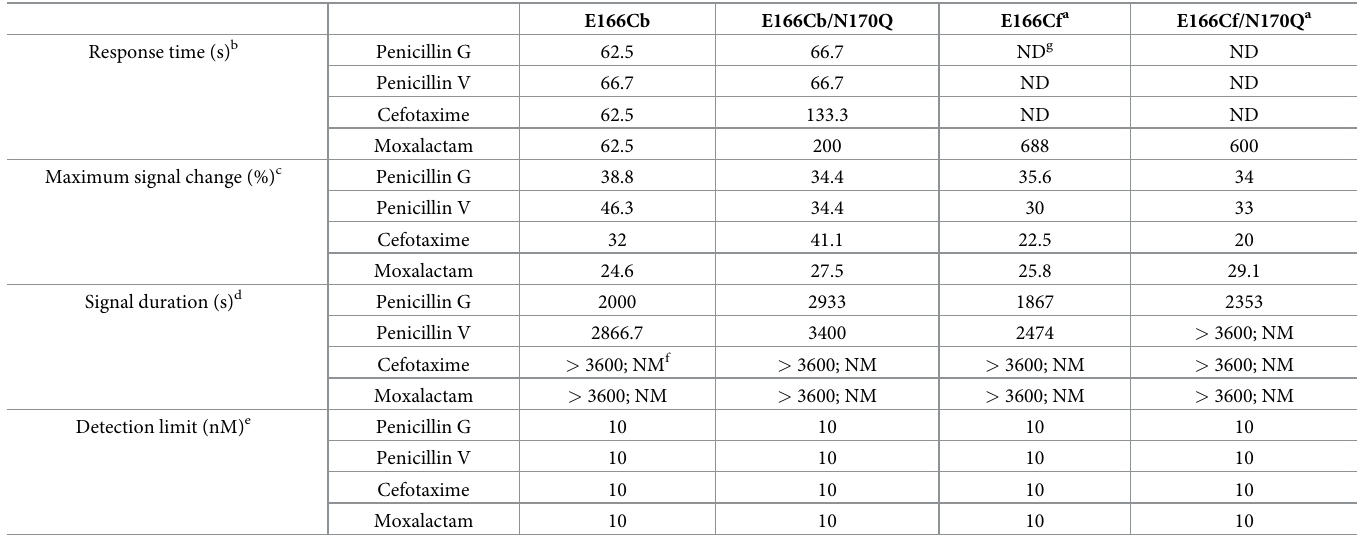
Table 1. Biosensor performance of fluorescent β